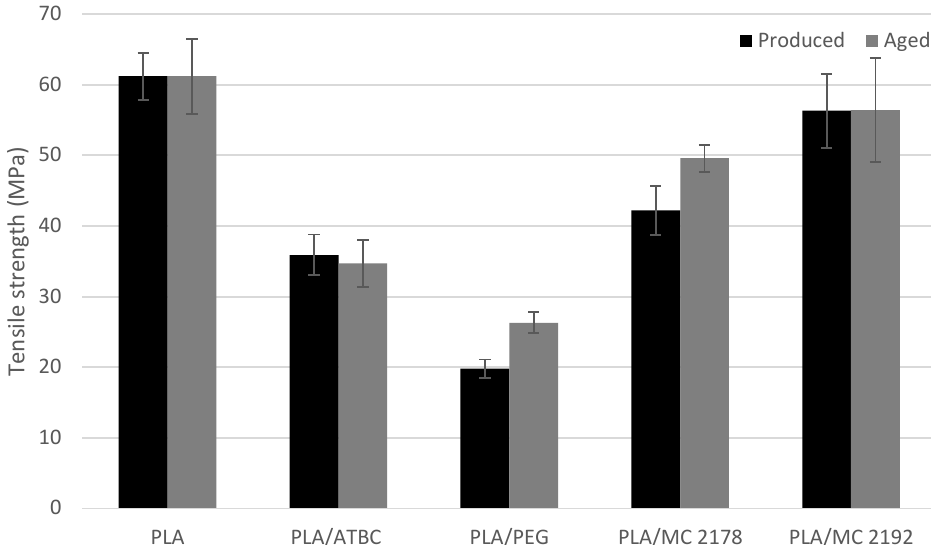
Figure 2. The evaluated results of tensile strength for as-produced and aged PLA films.